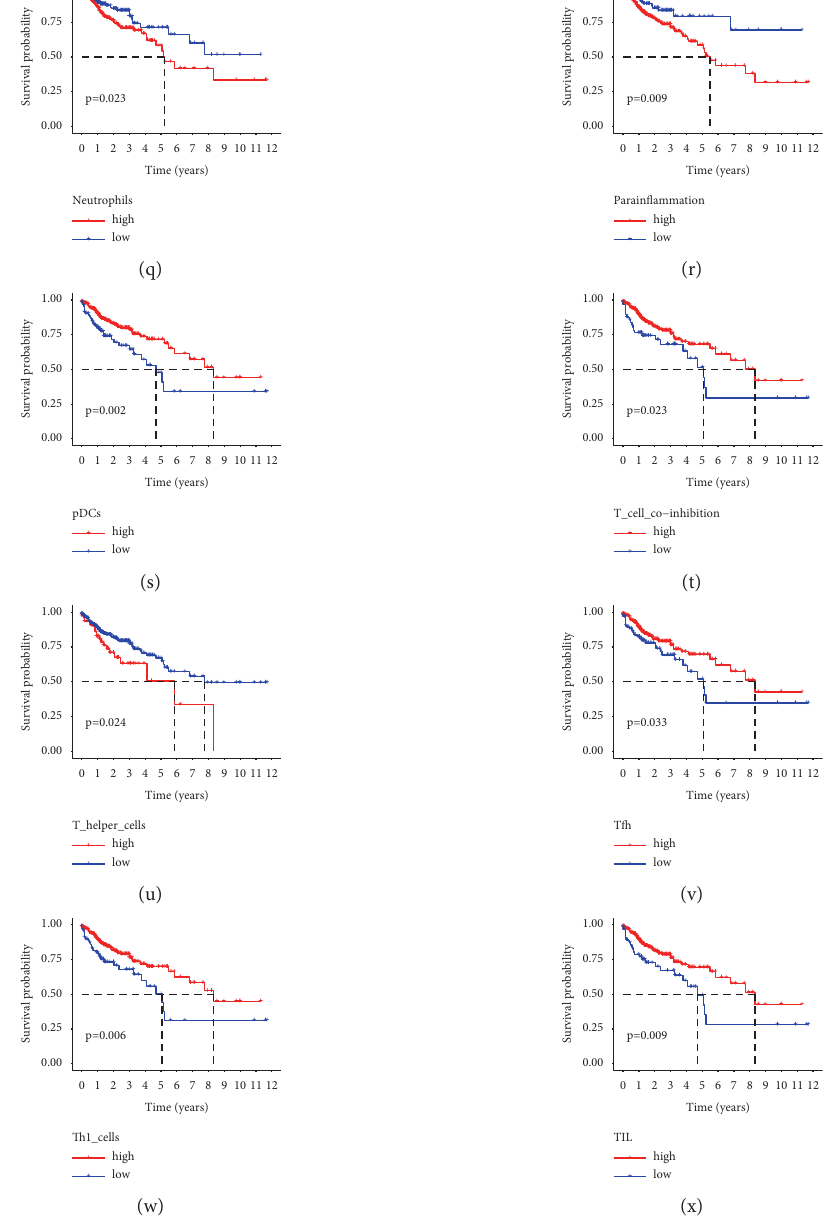
Figure 7: (a) The correlation of immunocyte infiltration fraction with risk score based on high- and low-risk groups. (b) The correlation of immune-related biological processes with risk score based on high- and low-risk groups. (c–g) Immunocyte infiltration cell survival analyses. (h–x). Immune-related biological processes survival